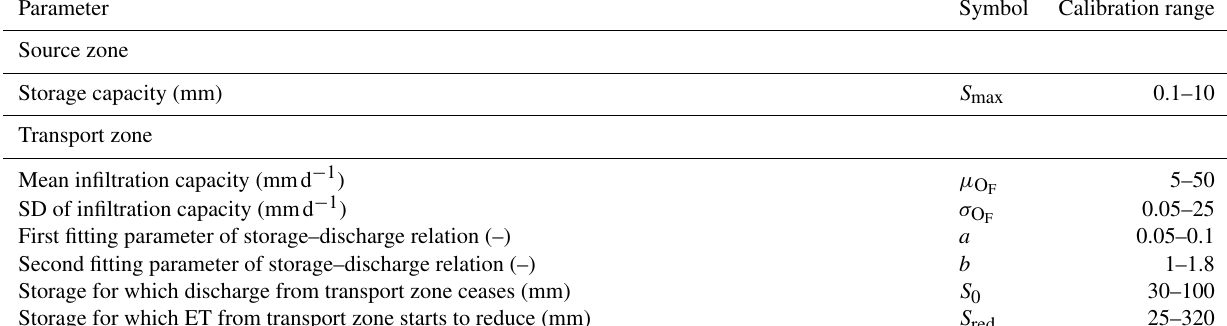
Table 3. Parameters of the hydrological and pesticide model with the lower and upper bounds of the parameter values for model calibration.